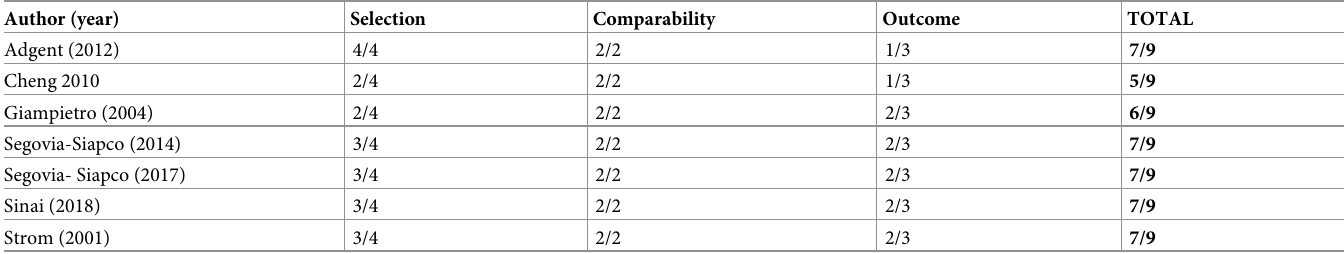
Table 3. Newcastle–Ottawa Scale for observational studies.